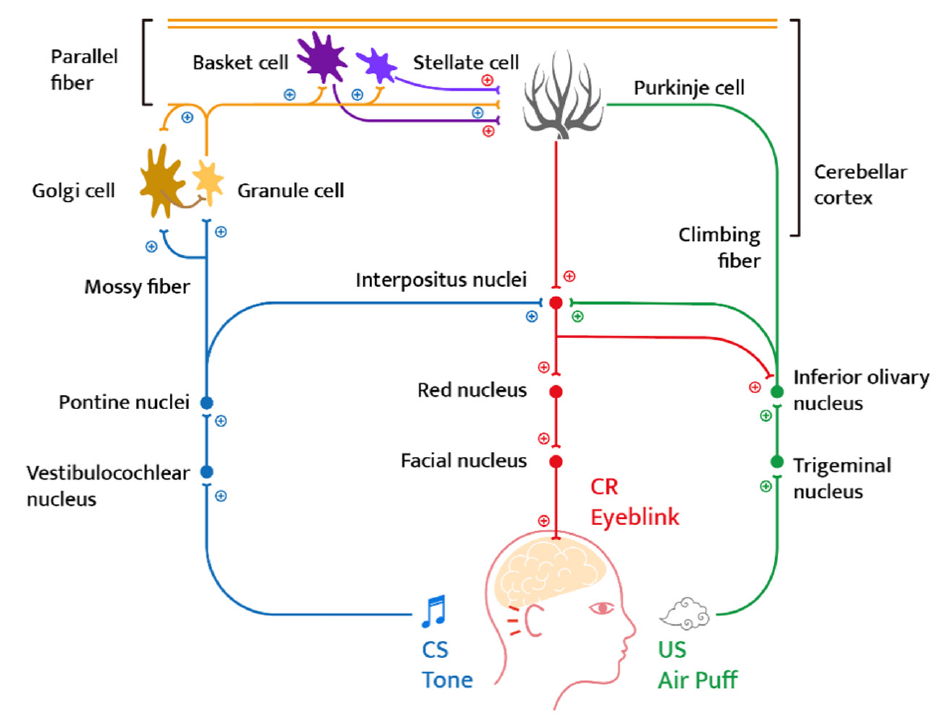
Figure 1. Essential neural circuitry of blink conditioning (reconstitution). (Source: Dominic T. Cheng et al., [8] “Eyeblink classical conditioning in alcoholism and fetal alcohol spectrum disorders”,